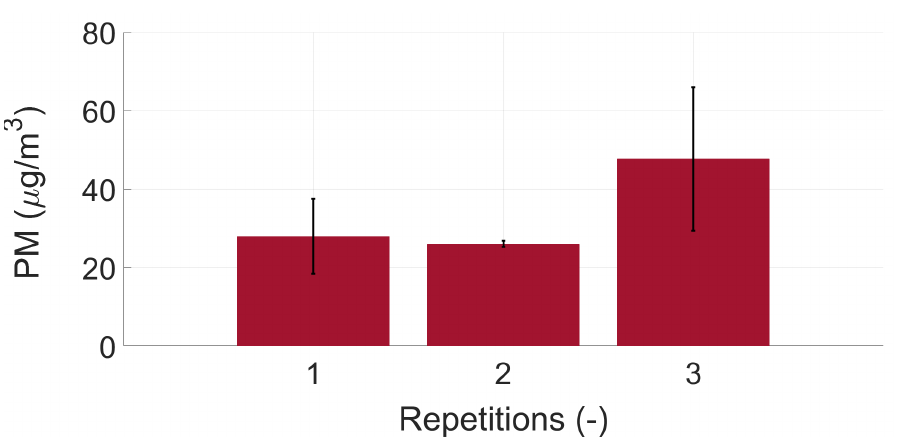
Figure A5. The mean values of PM measurements of